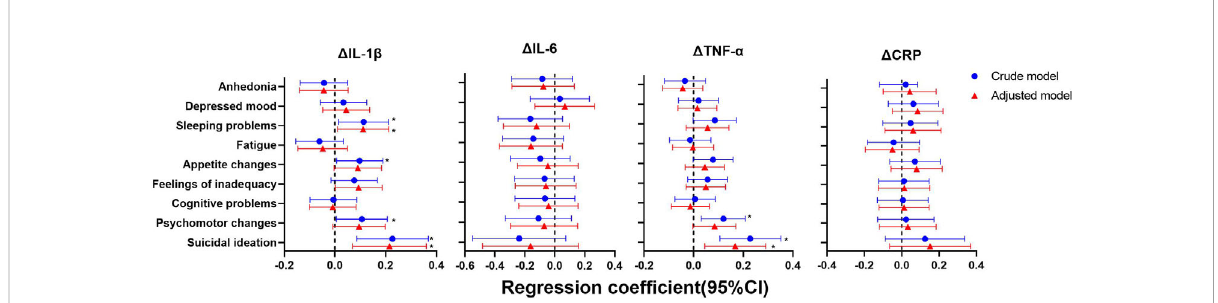
FIGURE 6 Generalized linear models of the associations between symptom-speci fi city of depressive symptoms at baseline and changes in in fl ammatory biomarkers between follow-up and baseline (n=248). IL-1 b , interleukin-1 b ; IL-6, interleukin-6; TNF- a , tumor necrosis factor- a ; CRP, C reactive protein. a The blue plot represented the crude model which was not adjusted by any variables, the red plot represented adjusted model which was adjusted by residential area, self-reported family economy, self-rated health condition, father ’ s education level, mother ’ s education level, cigarette use and alcohol use. b D represented changes between 2-year follow-up with